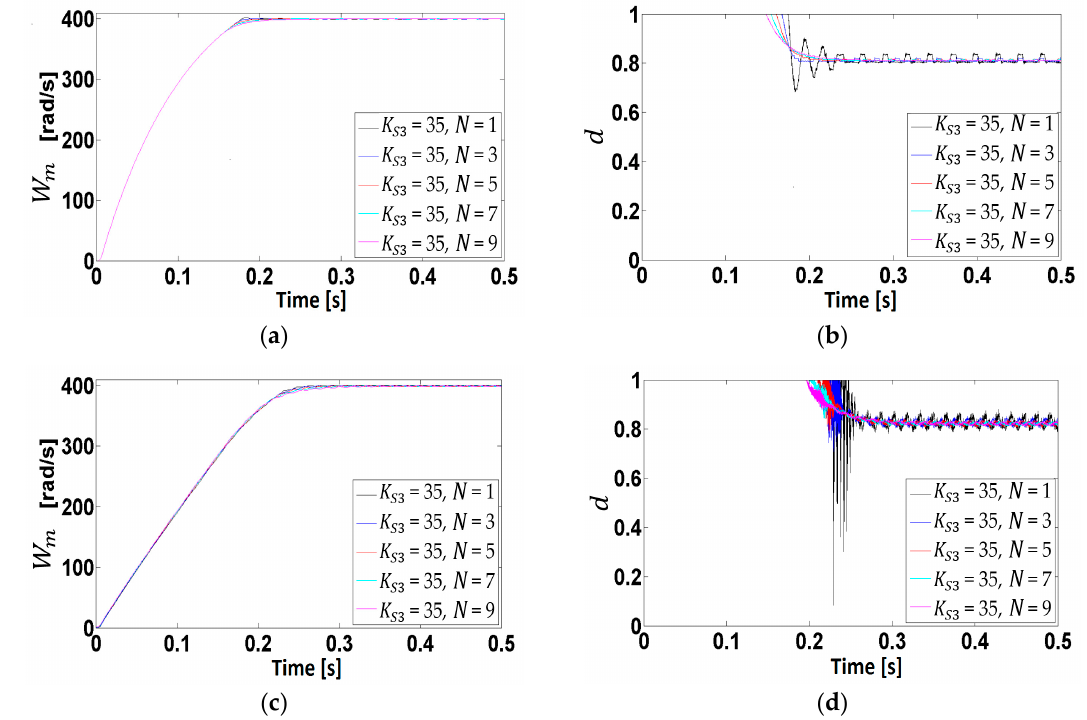
Figure 9. Behavior of the buck-motor system in closed-loop while changing N with K S 3 = 35: ( a ) output W m for the simulation; ( b ) d for the simulation; ( c ) output W m for the experiment; and ( d ) d for the experiment.